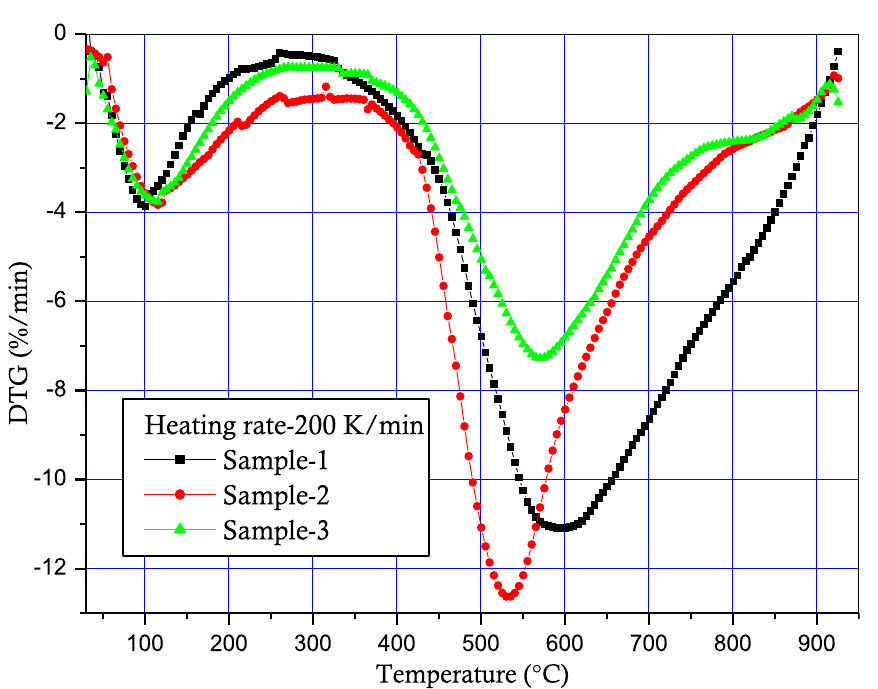
Fig. 7 DTG curves for low rank coal at heating rate 150 K/min